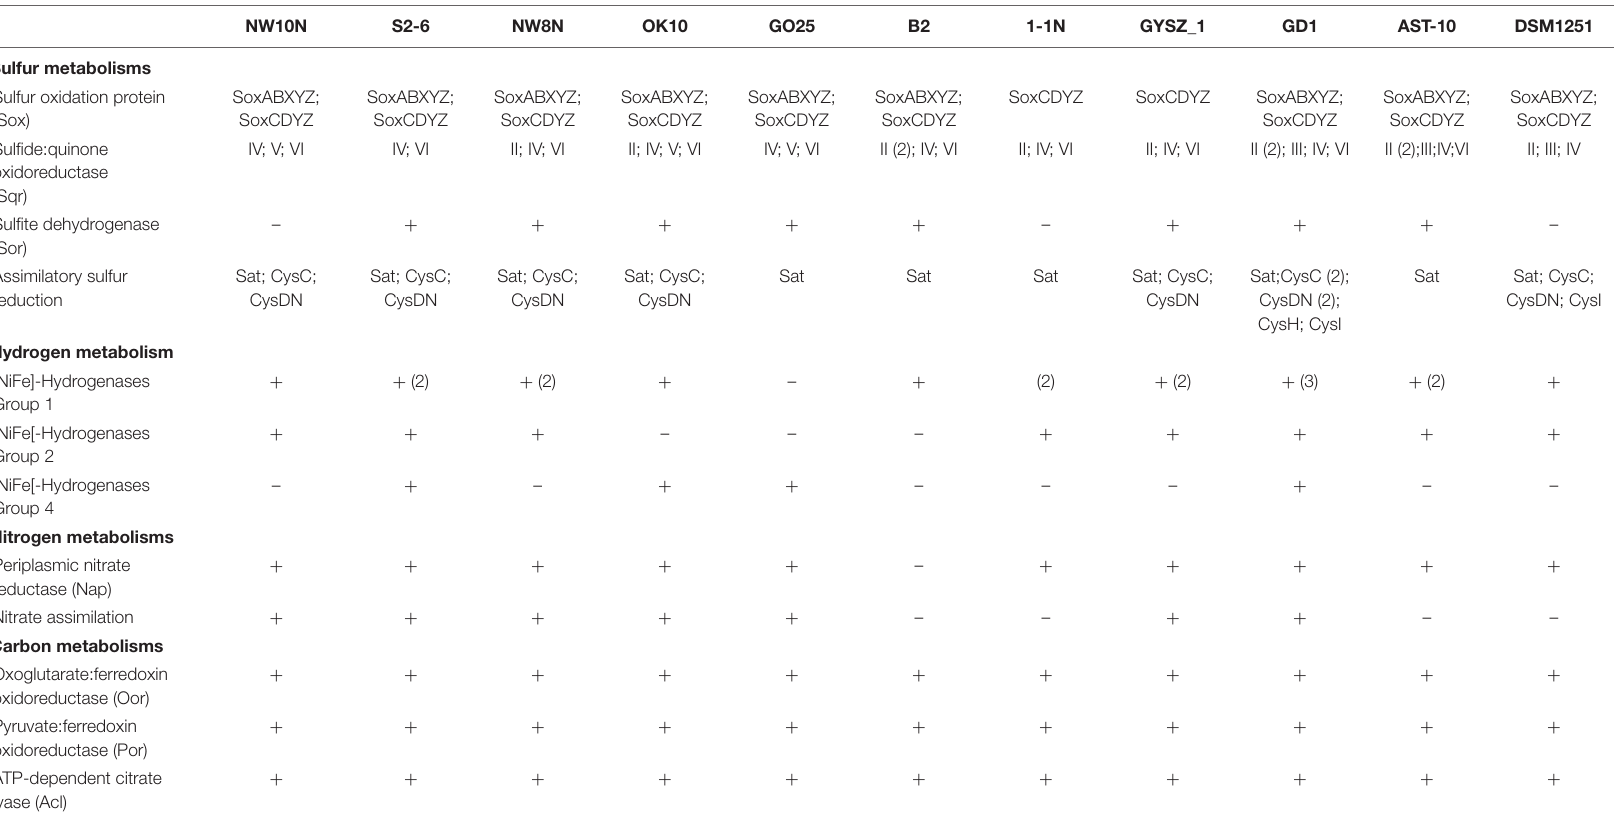
TABLE 3 | Comparison of key enzymes for sulfur, nitrogen, hydrogen, and carbon metabolisms in Sulfurimonas species based on RAST annotations in this